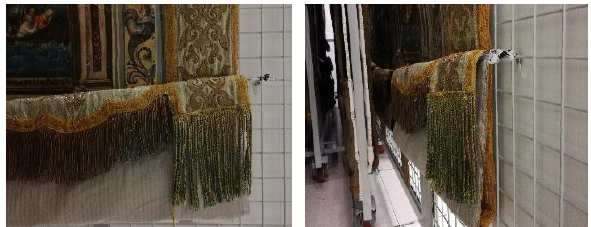
Figure 23 - Suspension of long pendants with textile